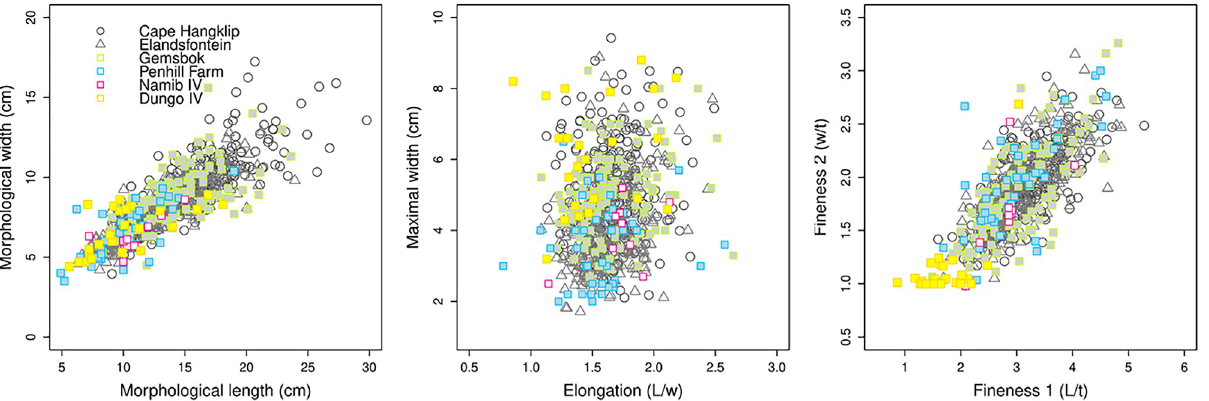
Fig 14. Comparative biplots of morphometric patterns for the shaped tools from Cape Hangklip, Elandsfontein, Gemsbok, Penhill Farm, Namib IV and Dungo IV. Data are available in S3 Table.